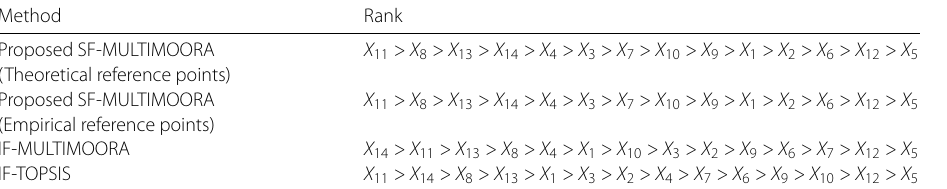
Table 10 The results of a traditional MULTIMOORA SWAM Score Rank RP Rank SWGM Score Rank X